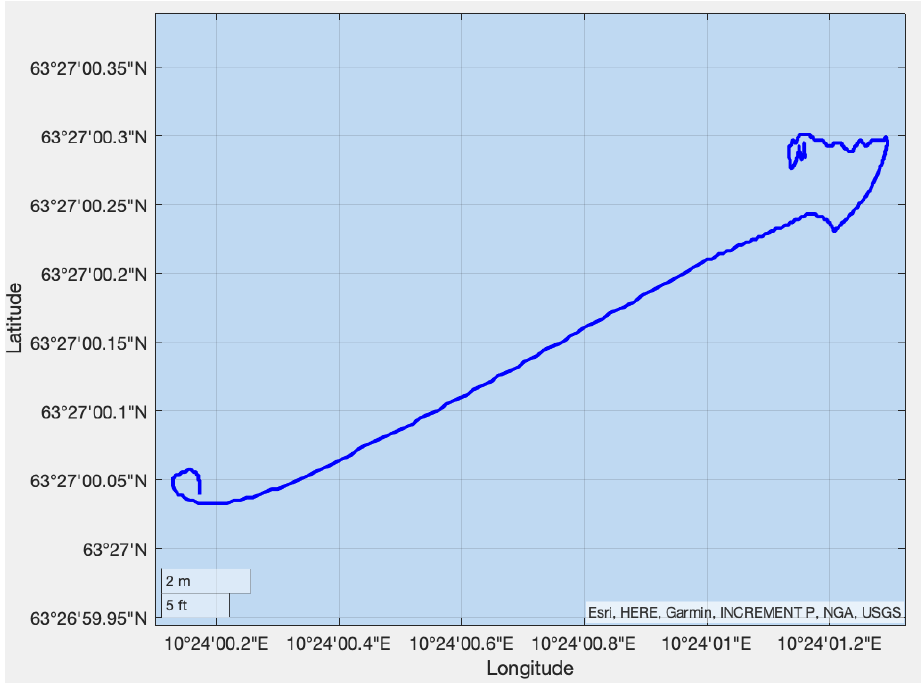
Figure 9. The blue line shows the path of the Otter USV when operating in the harbor (upper plot) and in the middle of the Trondheim fjord (lower plot). The starting points are 63 ◦ 26 (cid:48) 22.37 (cid:48)(cid:48) N and